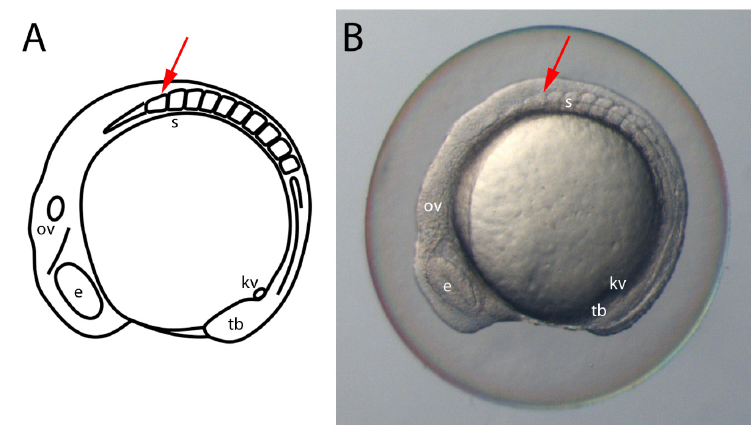
Figure 1. Staging embryos by somite counting. A schematic ( A ) and light-microscopy image ( B ) showing a lateral view of a 10 somite stage zebrafish embryo. The most anterior somite (red arrow) is slightly shorter and broader than more posterior somites. The generation of somites is tightly linked to the overall development of the embryo and therefore allows for accurate aging. e, eye; kv, Kupffer’s vesicle; ov, otic vesicle; s, somites; tb, tail bud.